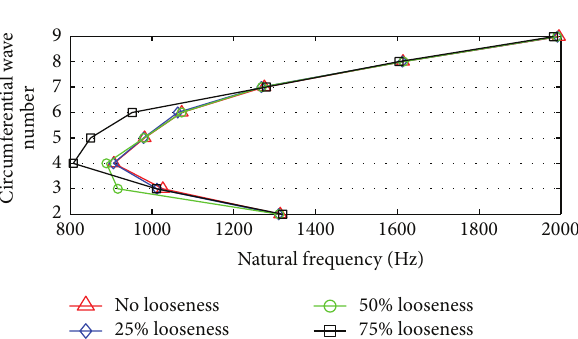
Figure 16: The relation between natural frequency and mode shape under BLB with different looseness